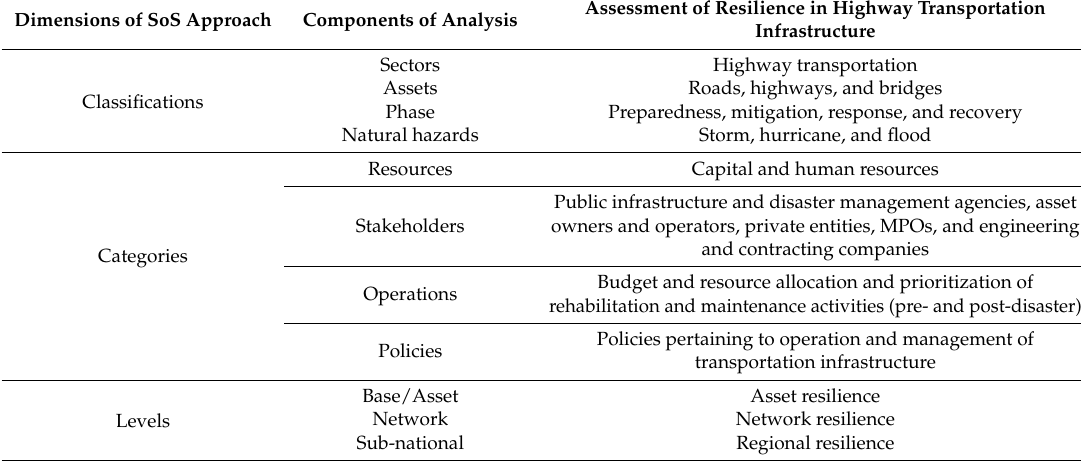
Table 1. Analysis of transportation infrastructure resilience using the SoS approach.